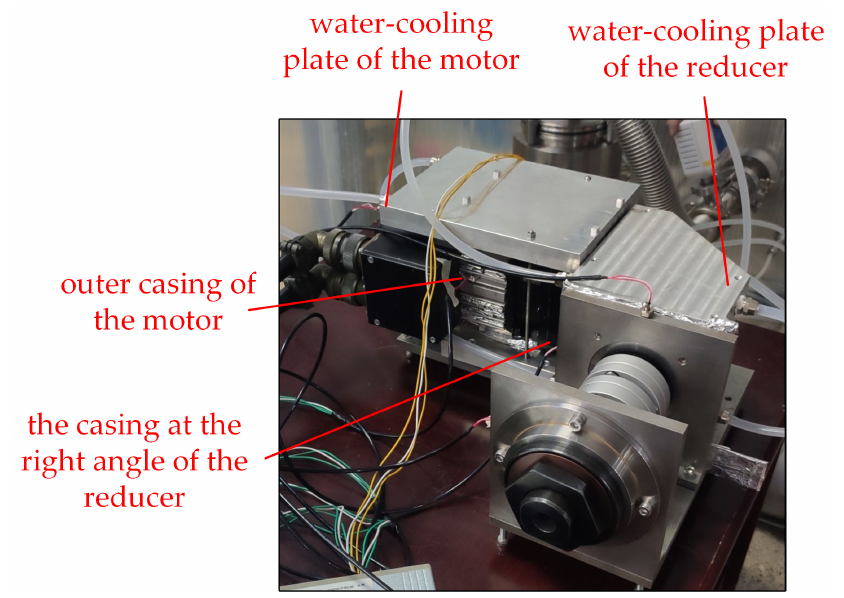
Figure 8. Sensor placement position of the test platform.